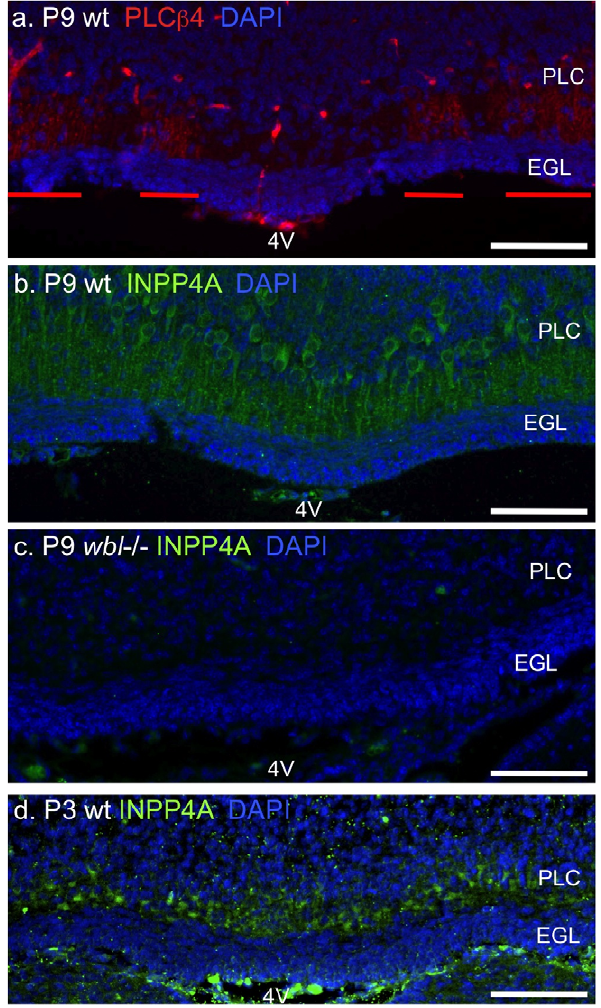
Figure 4. Inpp4a is expressed uniformly in Purkinje cells. Adjacent coronal sections from a wild-type P9 cerebellum labeled with anti-PLC b 4 (panel a), INPP4A (panel b) and mutant labeled with INPP4A (panel c). Coronal sections from wild-type P3 cerebellum show uniform Inpp4a labeling (panel d). Parasagittal striping of PLC b 4 is obvious at the midline superior to the 4 th ventricle (4V) in the P9 cerebellum(red bars). Sections are counterstained with DAPI, scale bar indicates 100 microns, PCL, Purkinje cell layer, EGL, external granule cell layer.